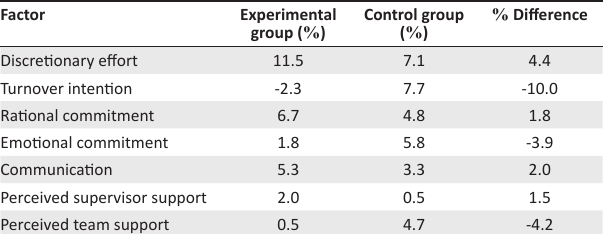
TABLE 7: Extent of differences between the experimental group and the control group over two years.